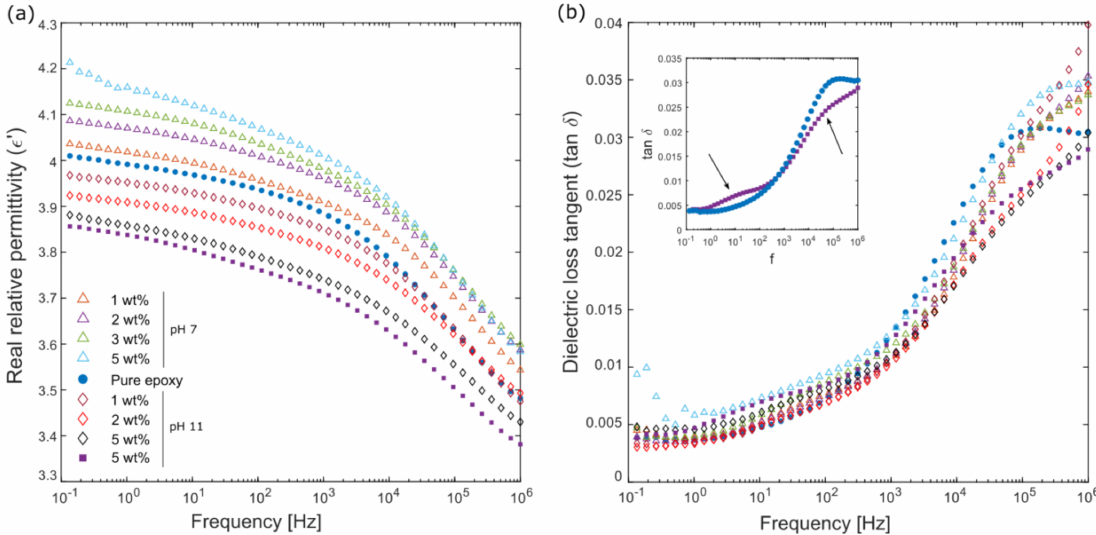
Figure 8. The complex permittivity of pure epoxy and epoxy nanocomposites with varying amounts of SiO 2 at room temperature. (cid:52) indicates samples prepared with pH 7 and indicates samples prepared with pH 11 (both with 1:10 (cid:51) of APTES:DGEBA), while (cid:4) indicates the sample prepared with pH 11 and 1:30 of APTES:DGEBA. ( a ) The real relative permittivity ( ε ’). ( b ) The dielectric loss tangent (tan δ ). The inset in ( b ) shows the same data for pure epoxy and epoxy-SiO 2 nanocomposite, with the arrows highlighting the different features in tan δ . The legend in ( a ) is common for both